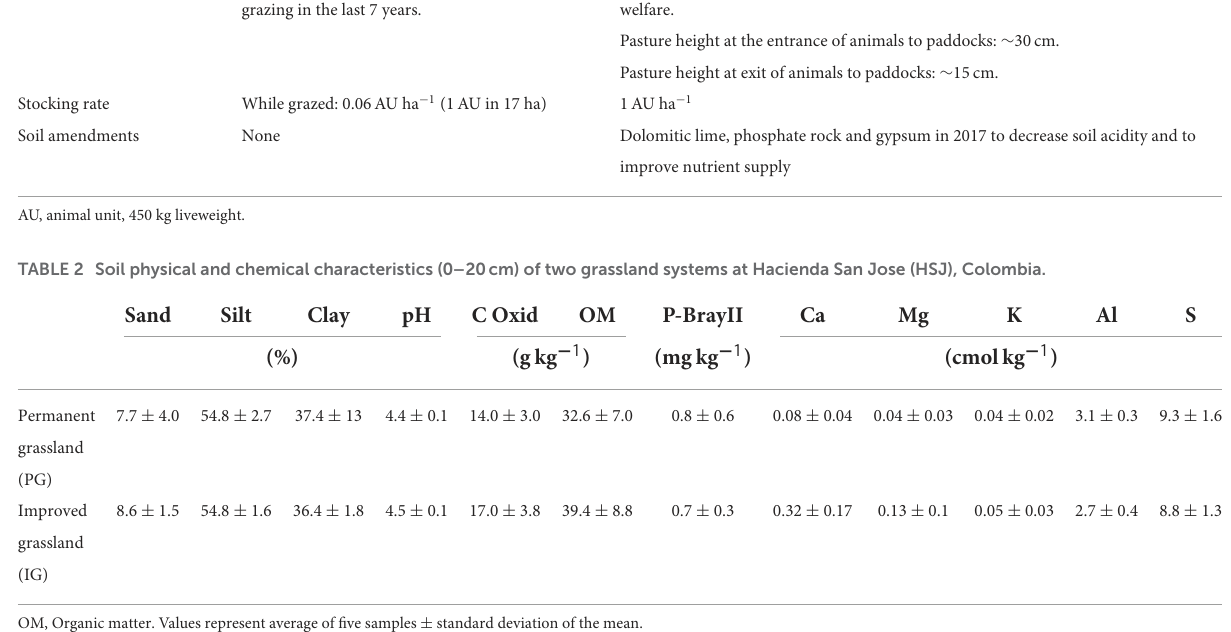
OM,Organicmatter.Valuesrepresentaverageoffivesamples ± standarddeviationofthemean.